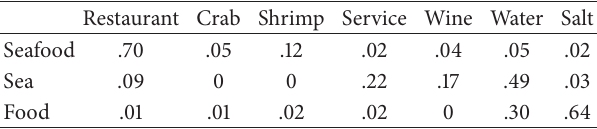
Table 1: The context vectors of Seafood, Sea, and